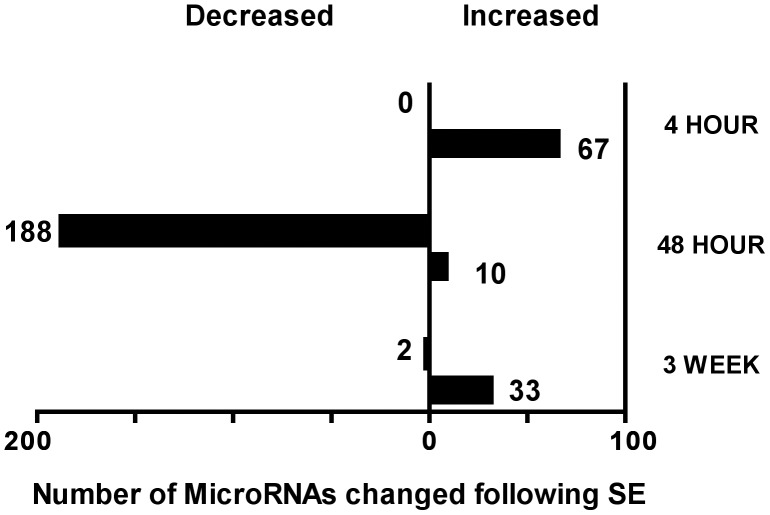
Total number of hippocampal microRNAs that are increased or decreased after SE at each time point.There are a large number of microRNAs that specifically decreased at 48 hours after SE. The specific microRNAs that change are listed on Tables 1, 2 and 3. We used a P value of 0.05 on a t-test to identify microRNAs that change.